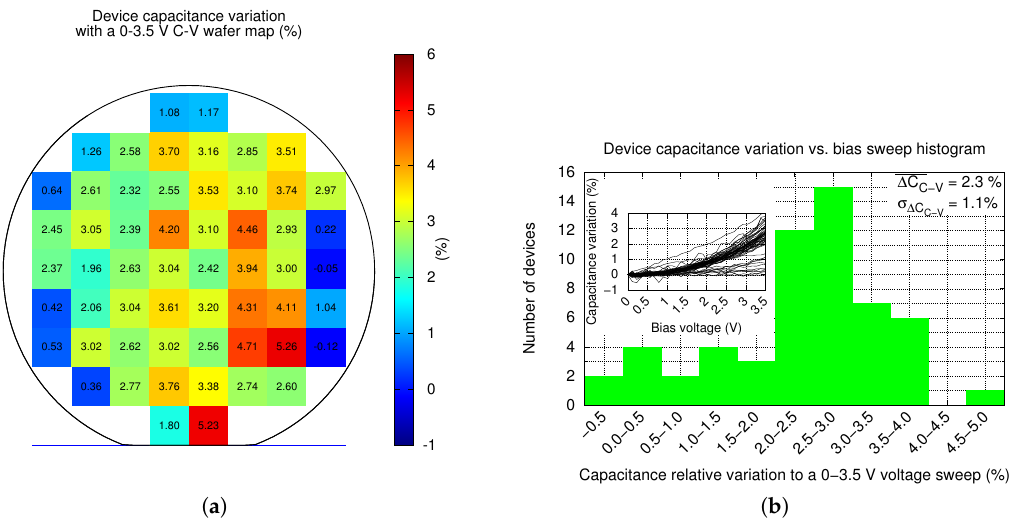
Figure 9. Wafer level measurements of device C-V normalized variation wafer distribution ( a ), and the histogram ( b ). All capacitance variation vs. biasing voltage sweeps are included in the inset of the